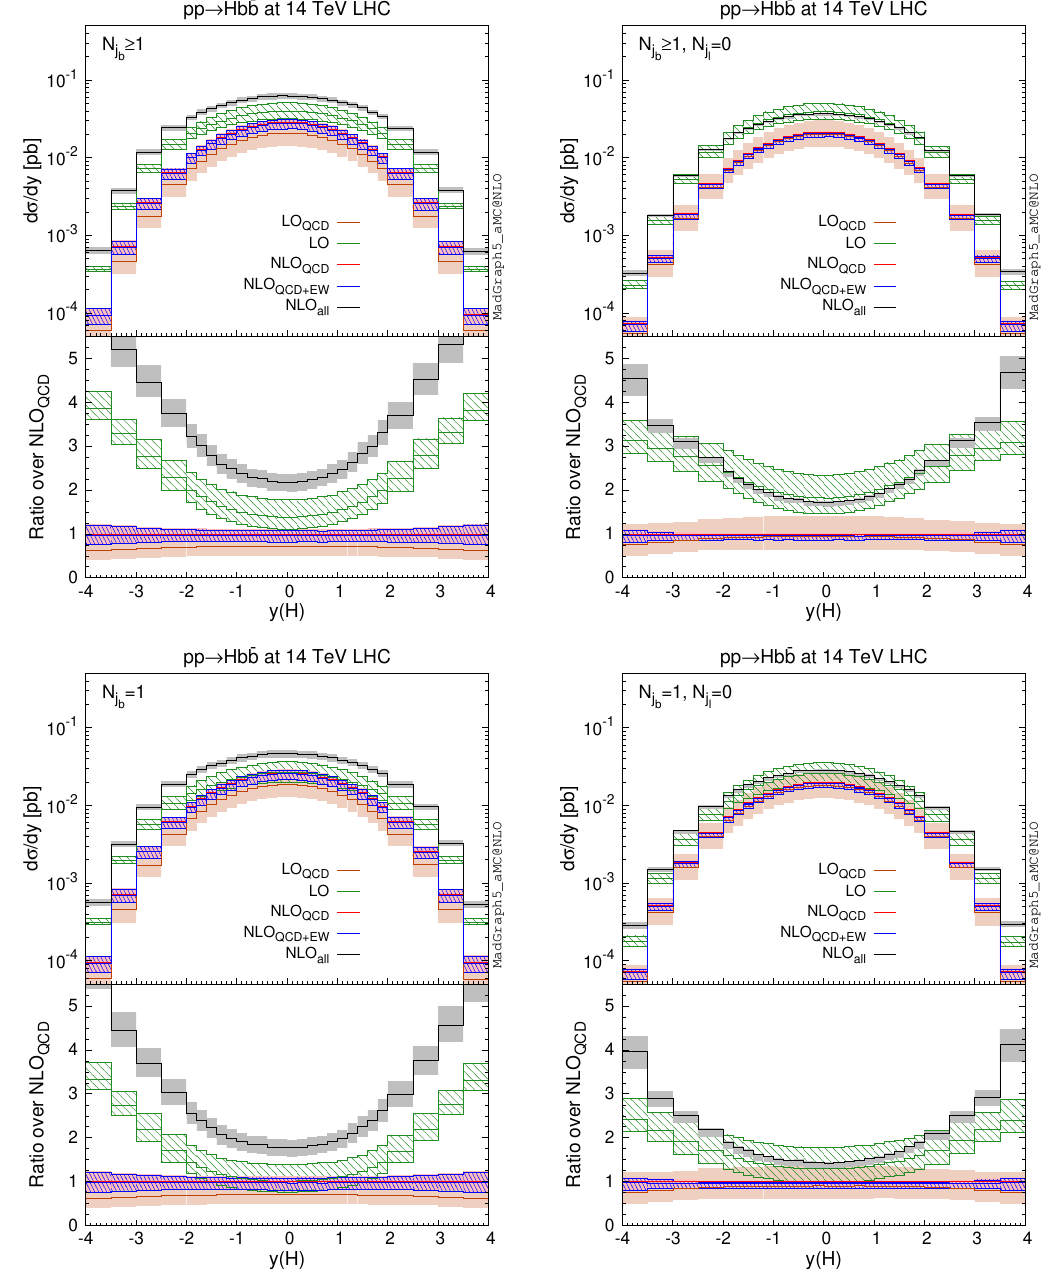
Figure 6 . The y ( H ) distribution for N j light-jet veto is